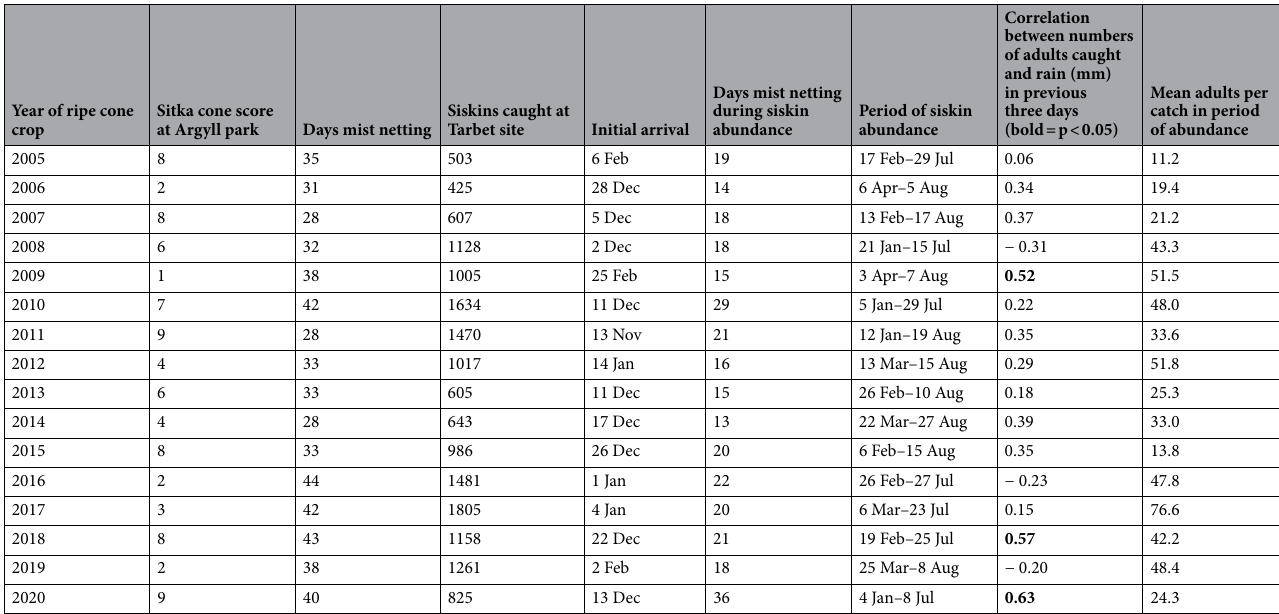
Table 1. Summary of